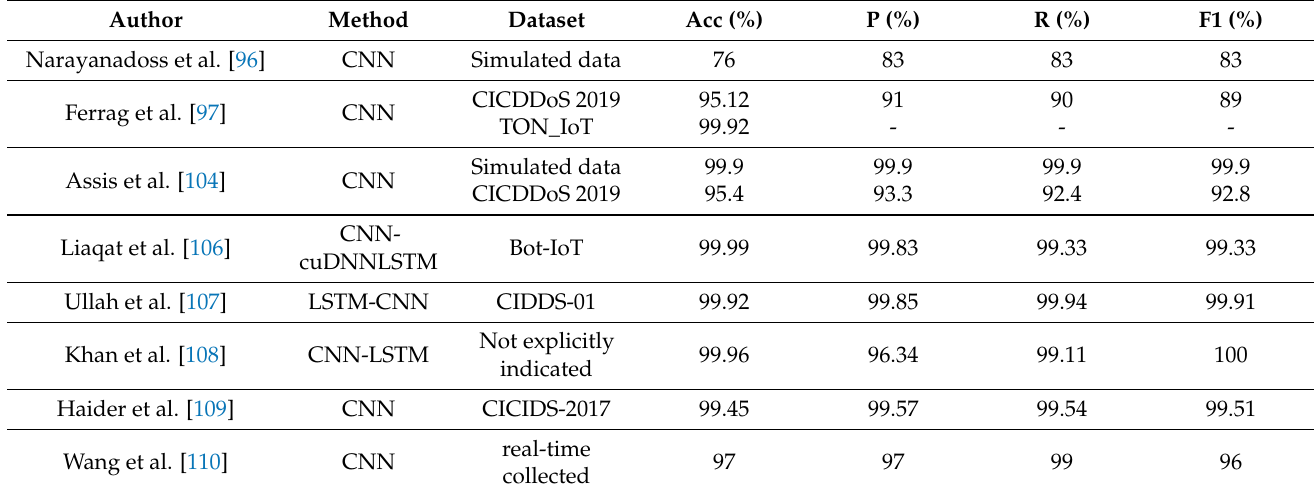
Table 6. Summary of BotNet attack Detection using Convolutional Neural Network in an SDN- enabled IoT